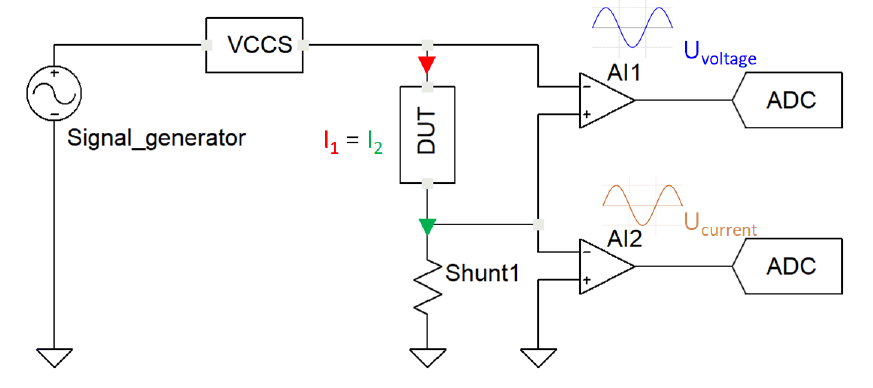
Figure 3. UI measurement